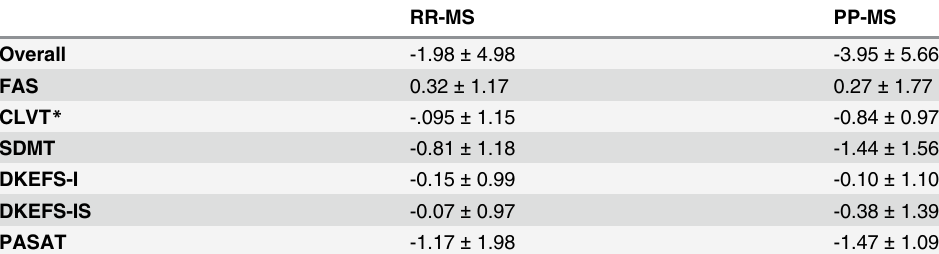
Table 2. Mean and standard deviation of Z-scores on neuropsychological